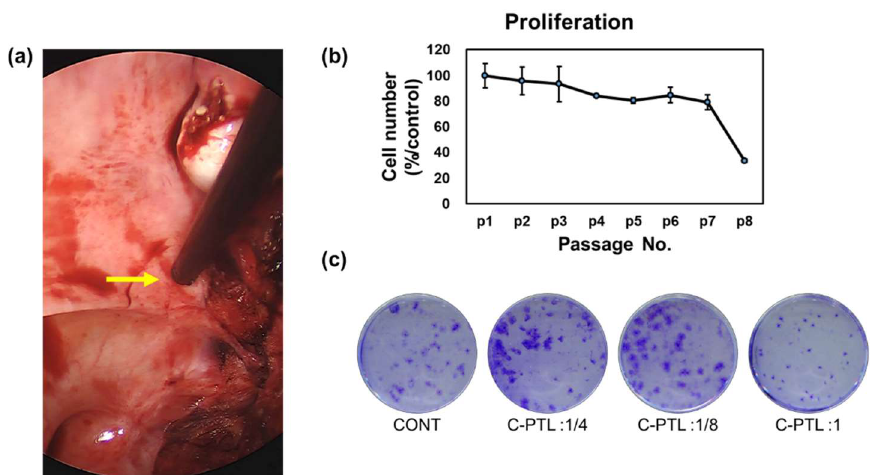
Figure 2. Characterization of hUSLF. Picture of uterosacral ligament during laparoscopic-assisted vaginal hysterectomy. The arrow indicates the uterosacral ligament ( a ). Proliferation of pelvic organ prolapse human uterosacral ligament fibroblasts (hUSLF) from passage 1 to passage 8 ( b ). Colony formation ability of hUSLF prepared with plasma-treated liquid in 1:4, 1:8, and 1:1 dilution ( c ).